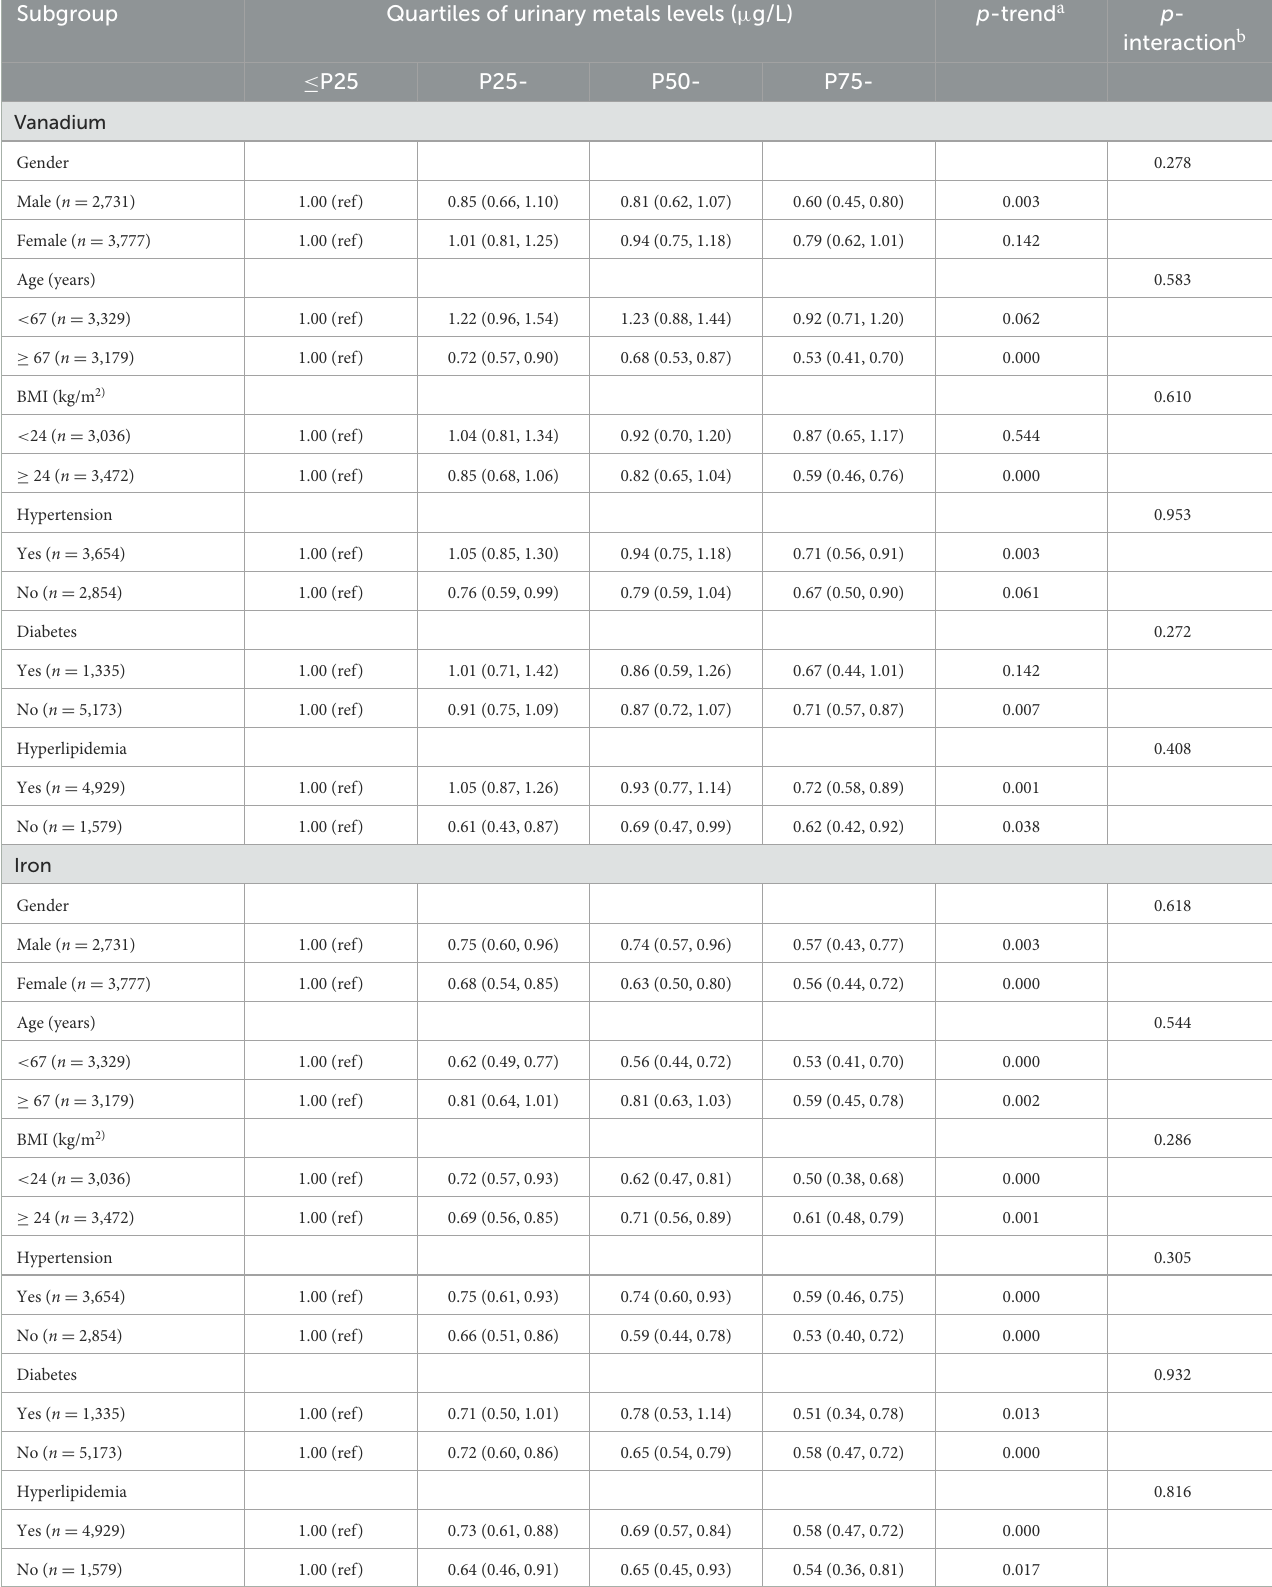
TABLE 2 Subgroup analysis of urinary metal vanadium, iron, nickel, zinc, and arsenic with hyperuricemia risk (OR, 95% CI). Subgroup Quartiles of urinary metals levels ( µ